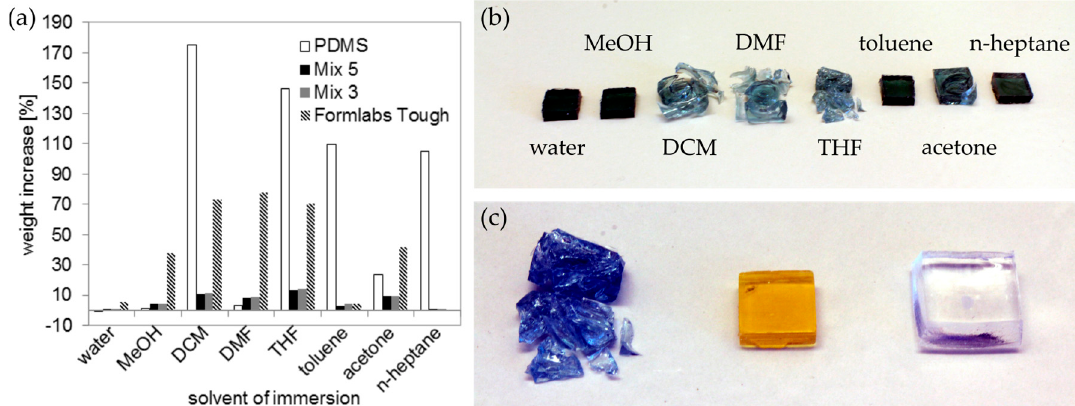
Figure 7. Solvent compatibility of printed PFPE methacrylates compared to poly(dimethylsiloxane) (PDMS) and the printed commercial stereolithography resin Formlabs Tough: ( a ) Rectangular 8 × 8 × 3 mm 3 blocks were immersed in eight different solvents and the weight increase was measured after 24 h. The PFPE blocks show a lower weight increase than the PDMS blocks and the Formlabs Tough resin, which were immersed in the solvents dichloromethane (DCM), tetrahydrofuran (THF), toluene, acetone, and n -heptane. Mix 5 (initiator: PPO, absorber: T326) and mix 3 (initiator: TPO, absorber: SOG) show a similar swelling, which demonstrates that the absorbers and initiators have no major impact on the swelling of the printed PFPE parts; ( b ) Polymerized Formlabs Tough resin after immersion in the respective solvents for 24 h. The parts were strongly damaged by DCM, dimethylformamide (DMF), THF, and acetone; ( c ) Photograph of a Formlabs Tough block (left) and a PFPE methacrylate block (mix 3, middle) and PDMS (right) after 24 h immersion in THF.